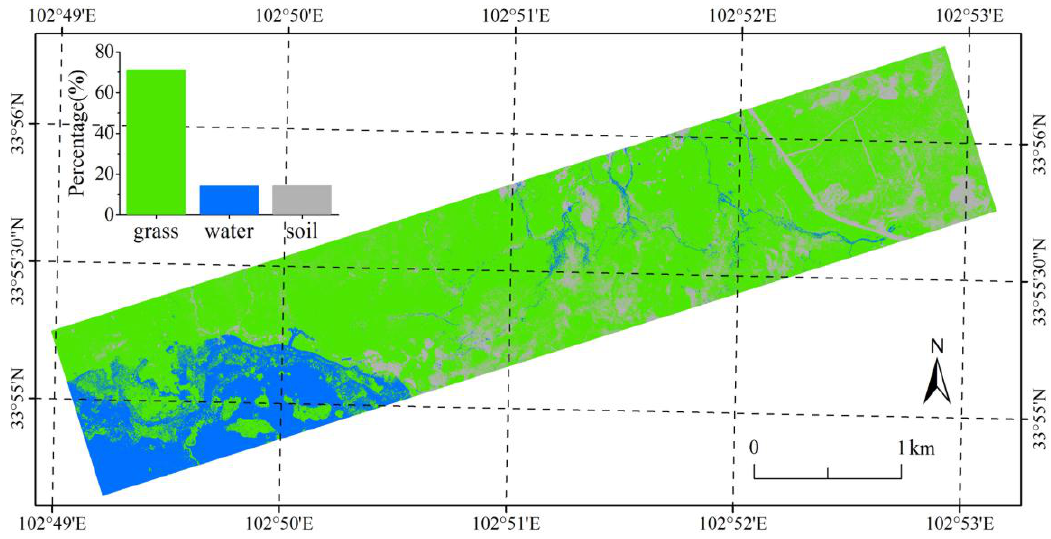
Figure 6. Classification map of the transect based on the UAV image acquired in July 2014. Table 2. Confusion matrix and accuracy estimates for the classified map.